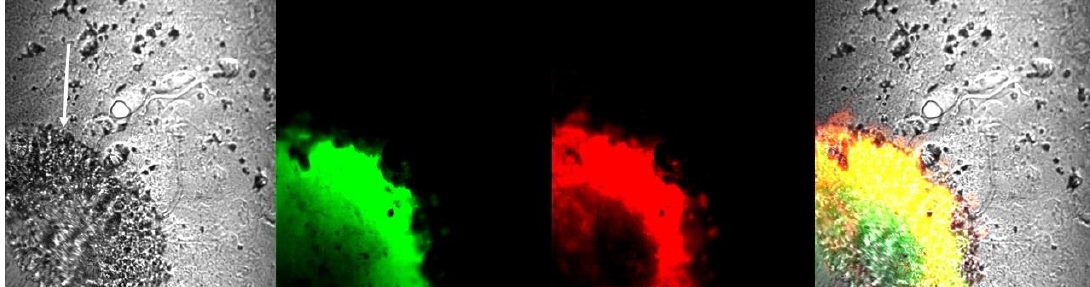
Figure 3. Aggregated amyloid visualized by staining with thioflavin T (green) and thioflavin S (red) inside the glioma tumor body. The white arrow shows the glioma tumor body visible in the brain slice.